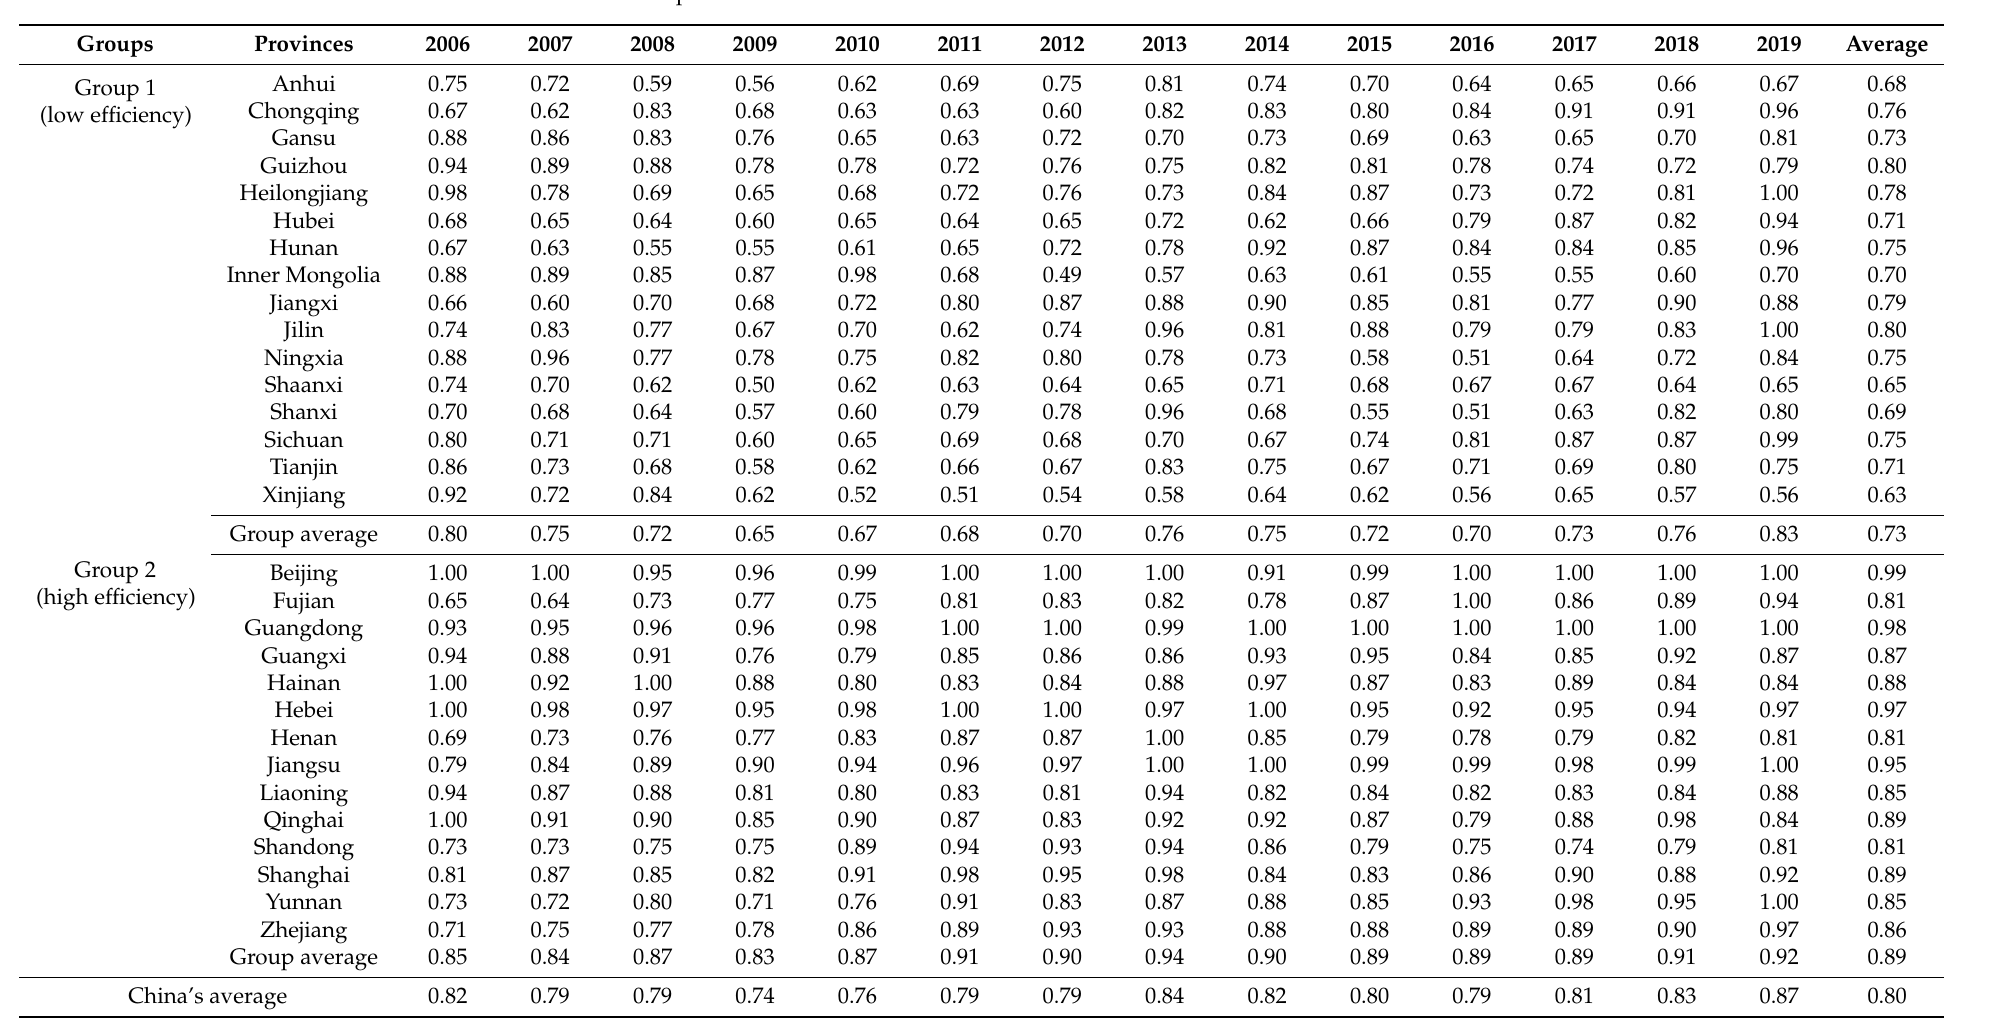
Table 4. OE measures of Chinese